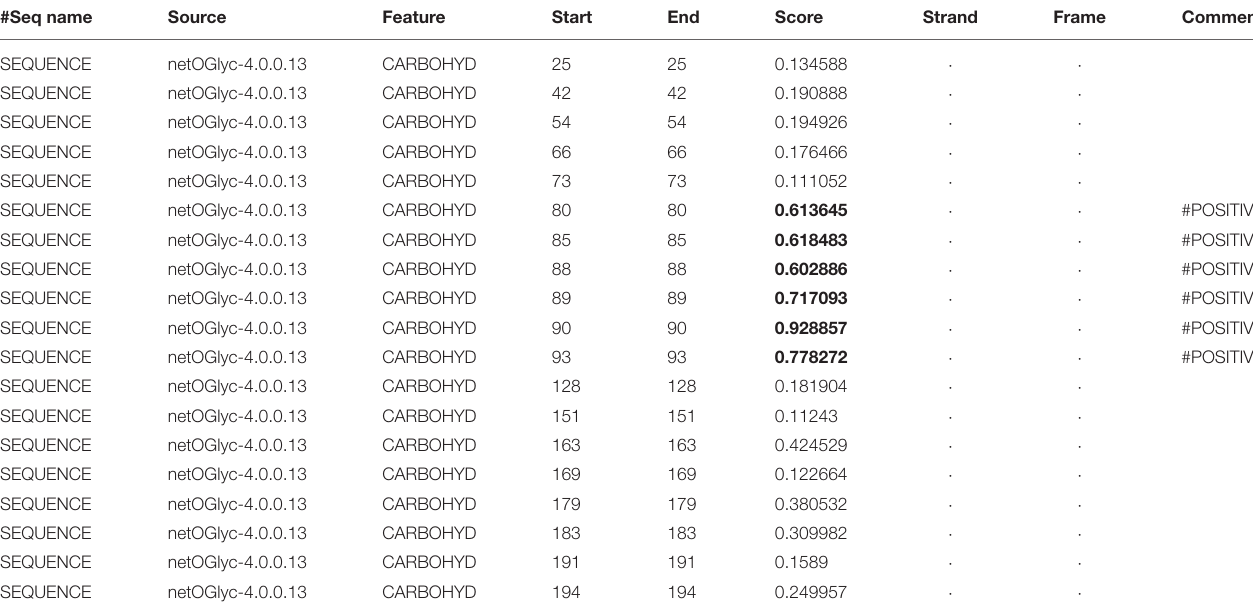
TABLE 8 | Prediction of O-glycosylation sites in hPRL (position 1–227) with NetOGlyc 4.0 Server with score more than